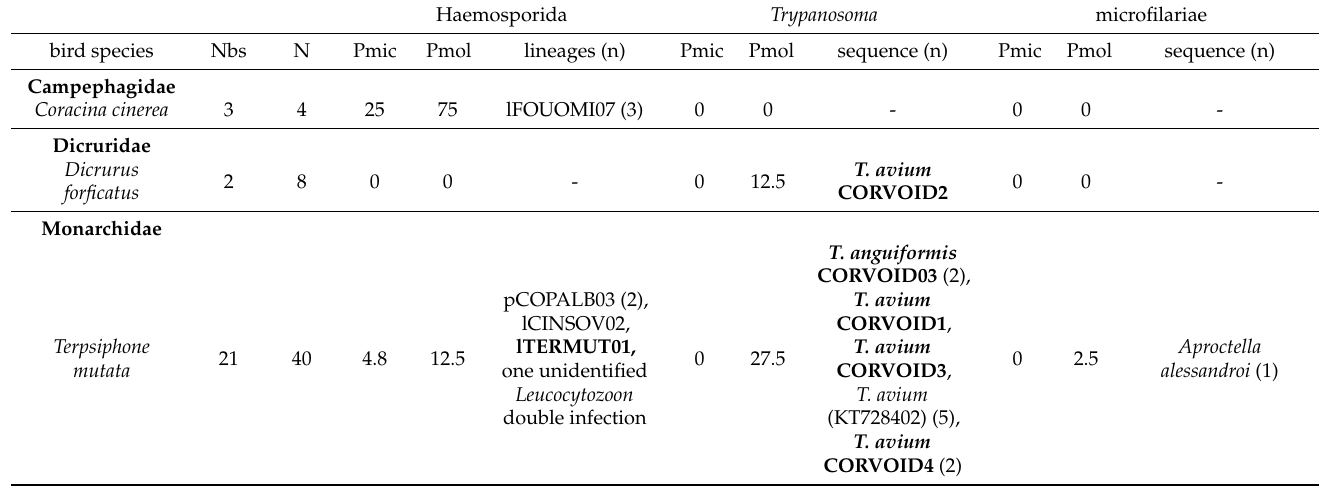
Table 1. Dataset of Corvoidea species examined in this study. Absolute numbers of blood smears (Nbs) and blood samples (N) are given. Results of parasite detections are listed for haemosporidian parasites, trypanosomes and filarioid nematodes, respectively. For each parasite taxon, percentages (%) of infected samples identified with microscopic method (Pmic) and molecular methods (Pmol), along with the name of the identified lineage/sequence, are given. “-” indicates that percentages were not measurable due to a lack of samples or that no sequence was amplified. If the parasite lineage/sequence was detected more than once, sample sizes are given in brackets. Newly detected lineages/sequences are given in bold